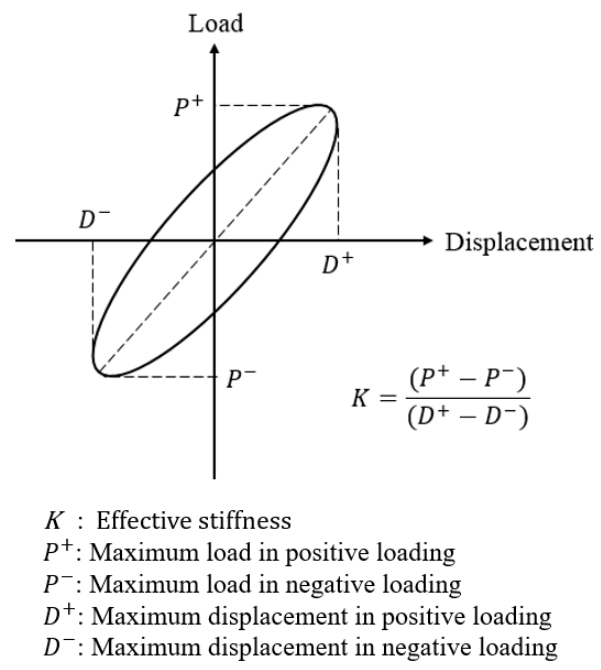
Figure 13. Calculation of effective stiffness. Table 5. Effective stiffness estimated from the experimental result. Values of Effective Stiffness (kN/mm) Effective Stiffness Ratio Drift Ratio (%)